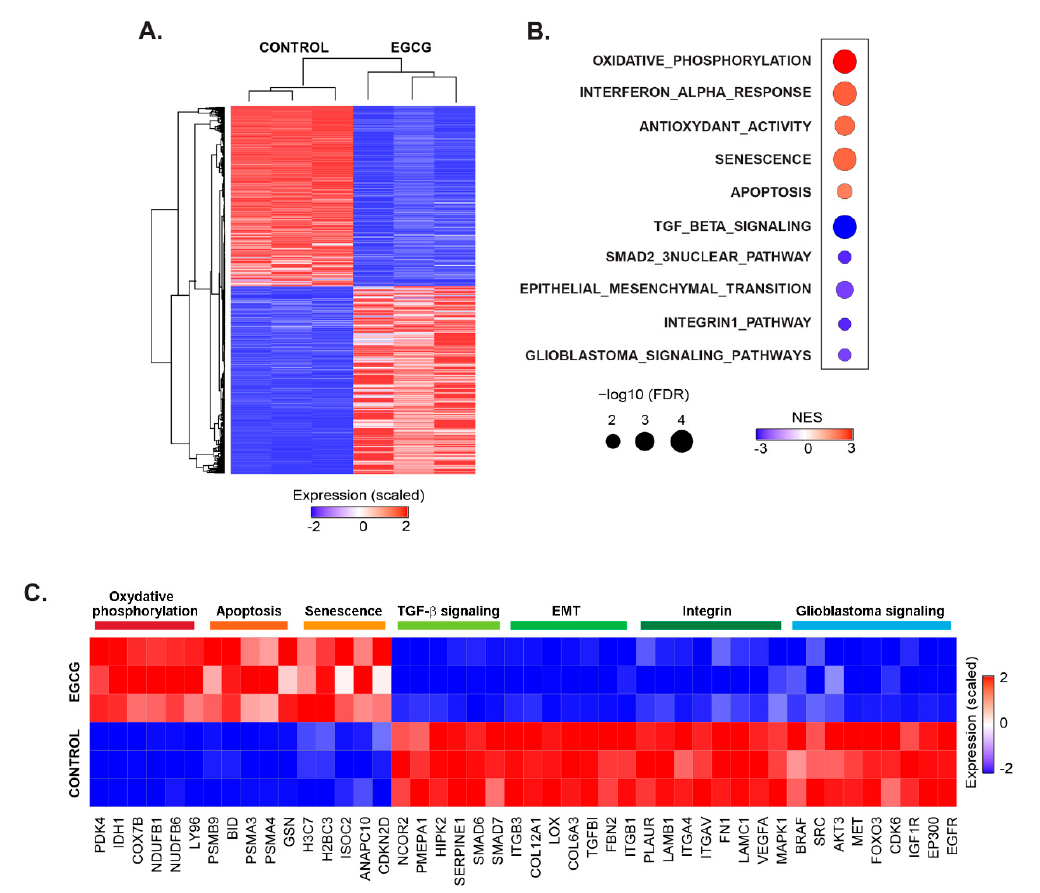
Figure 2. Transcriptomic analysis reveals the reversion of epithelial to mesenchymal transition in profit to an apoptotic program upon EGCG treatment of glioblastoma spheroids. ( A ) Total RNA was extracted from control- and EGCG- treated U87 spheroids from three independent experiments and subjected to RNA-Sequencing. Unsupervised hierarchical clustering of all the genes differentially expressed in pairwise comparison was tested with adjusted p value ≤ 0.05 and log2 fold change ≥ 1.0. ( B ) Dot plot showing changes in the normalized enrichment score (NES) for the most enriched pathways in EGCG-treated U87 spheroids compared to untreated control cells. FDR p value ≤ 0.05. The top up- and down-regulated gene signatures of Hallmark, Canonical pathways, and Gene Ontology. ( C ) Heatmap representation of the relative expression of known phenotypic markers for each indicated cellular